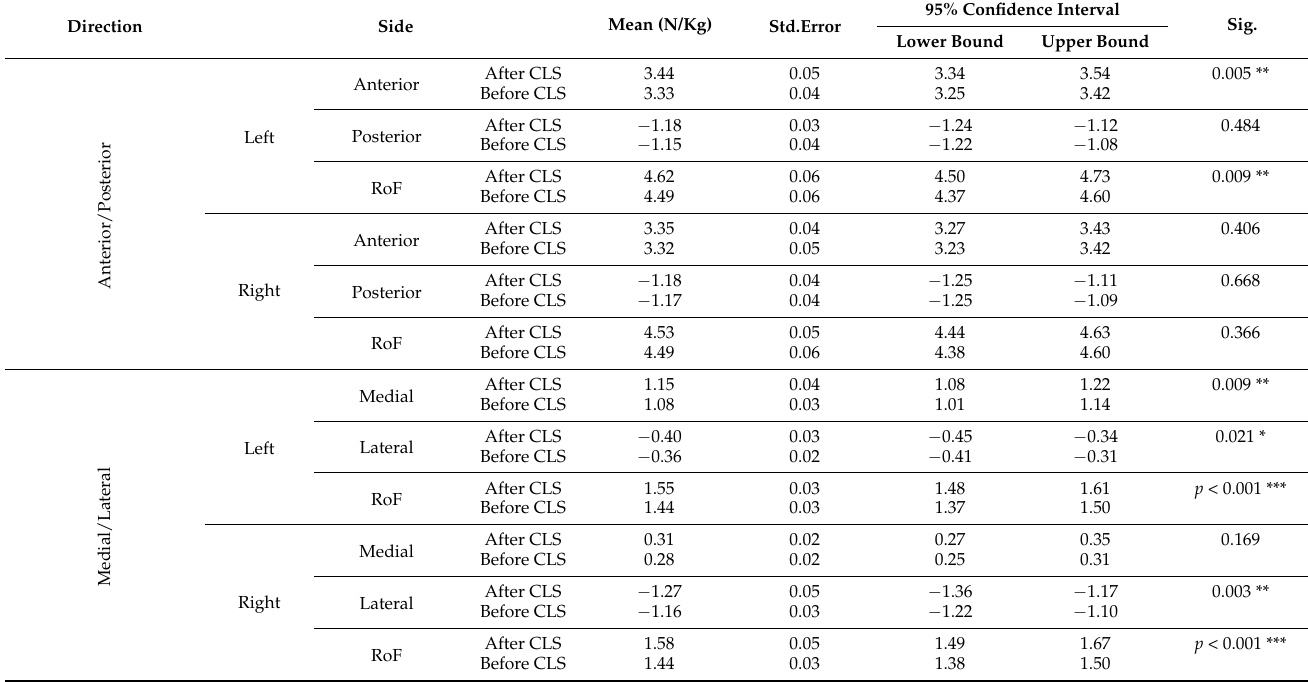
Table 7. Knee Joint Force in Anterior/Posterior, Medial/Lateral, and Tension/Compression